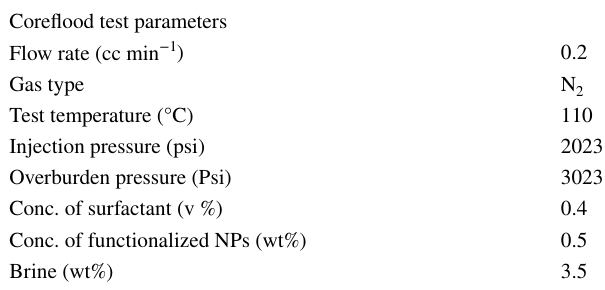
Table 3 Coreflood test conditions used to study (∆ p )